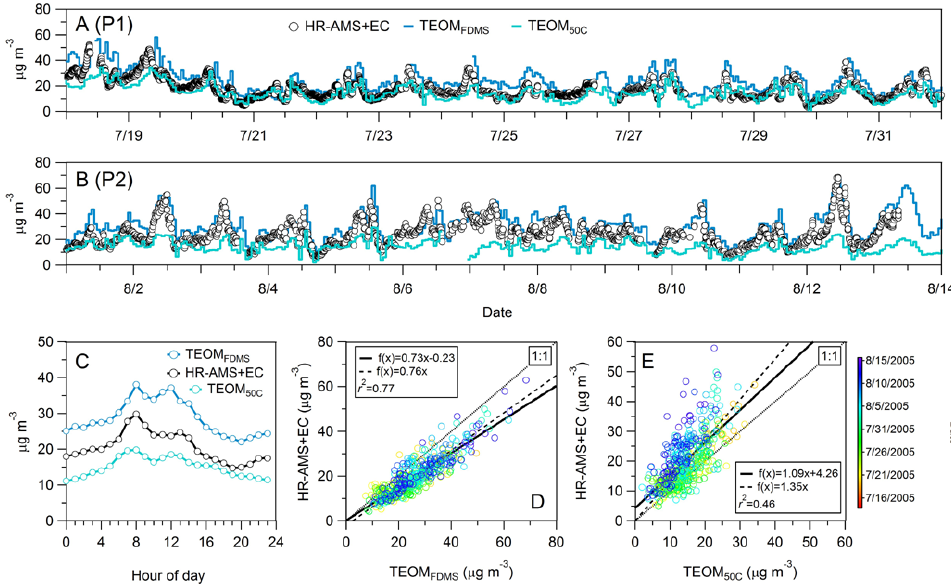
Fig. 2. Comparison of HR-AMS+EC, TEOM FDMS , and TEOM 50C . Time series of each measurement are shown in panels (A) and (B) over the periods 7/17–7/31 and 8/1–8/13, respectively, while panel (C) shows average diurnal profiles of HR-AMS+EC, TEOM FDMS , and TEOM 50C throughout the duration of SOAR-1. HR-AMS+EC concentrations are plotted against TEOM FDMS and the TEOM 50C concentrations in panels (D) and (E) , along with the results of linear regression, with and without a fixed-zero intercept, and coefficients of correlation ( r 2 )